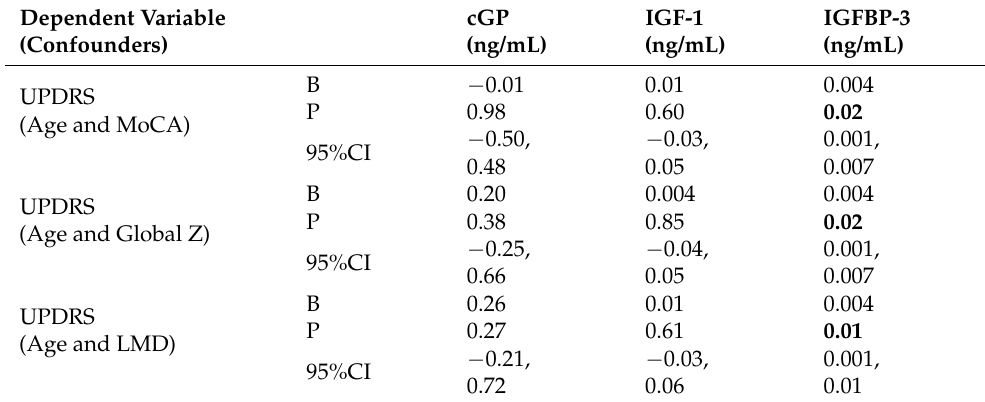
Table 1. Correlation between plasma concentration of IGFBP-3 and motor